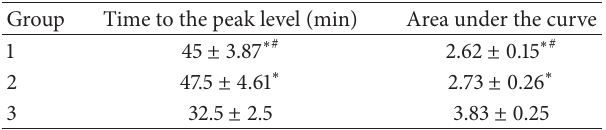
Table 1: Maltose absorption